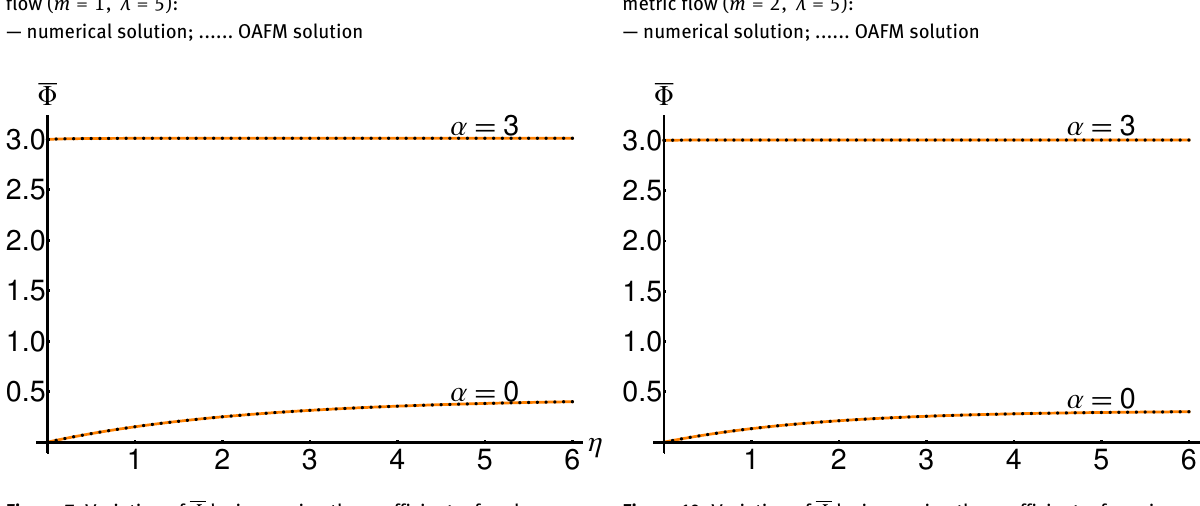
Figure 10: Variation of Φ by increasing the coeflcient α for axisym- metric flow ( m = 2, λ = 10) : — numerical solution; ...... OAFM